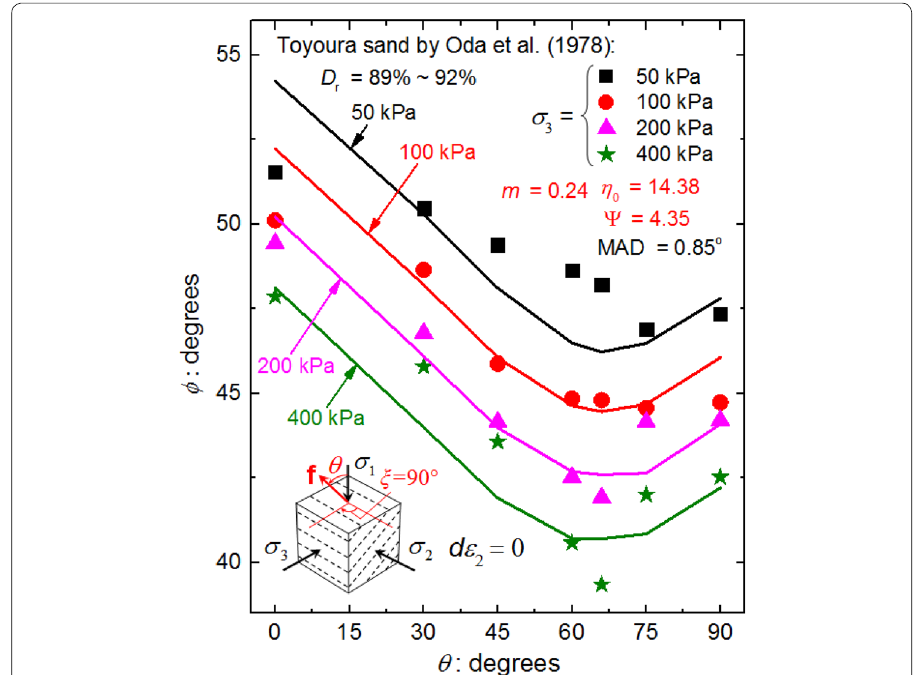
Fig. 17 Comparison between plane strain compression test results of Toyoura sand by Oda et al. [7] and predictions by this study